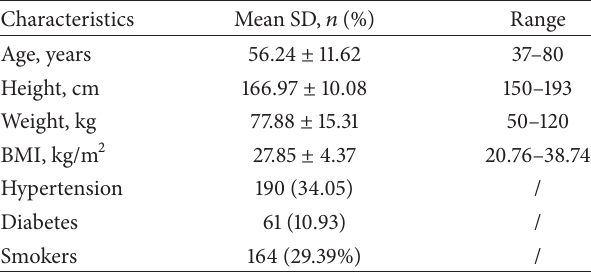
Table 1: Demographic characteristic of the